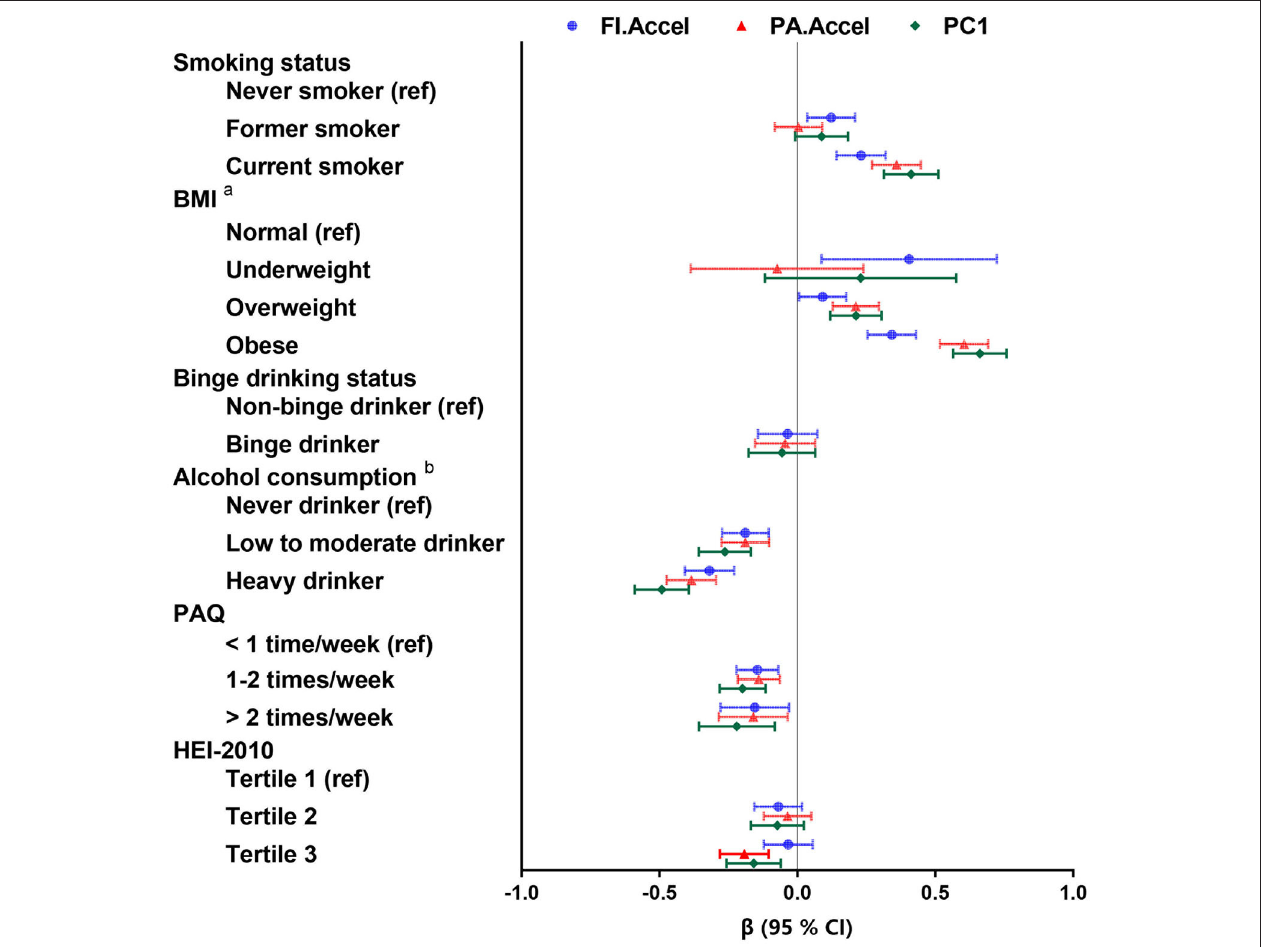
FIGURE 4 | The responses of different aging measures to modifiable life style factors. Coefficients ( β ) and 95% confidence intervals (CI) were calculated via linear regression adjusted for chronological age and gender. PA.Accel and FI.Accel represent residuals from linear models when regressing telomere length, Phenotypic age and frailty index on chronological age, respectively. PC1, the first principal component of PA.Accel and FI.Accel through the principal component analysis; BMI, body mass index; PAQ, leisure time physical activity level; HEI, health eating index. a Alcohol consumption was defined as never drinker (never drinking or didn’t drink in past year), low to moderate drinker (drinks < 3 times per month), and heavy drinker (drinks at least one time per week). b Underweight was defined as BMI < 18.5 kg/m 2 ; normal was defined as 18.5 ≤ BMI < 25.0 kg/m 2 ; overweight was defined as 25.0 ≤ BMI < 30.0 kg/m 2 ; and obese was defined as BMI ≥ 30.0 kg/m 2